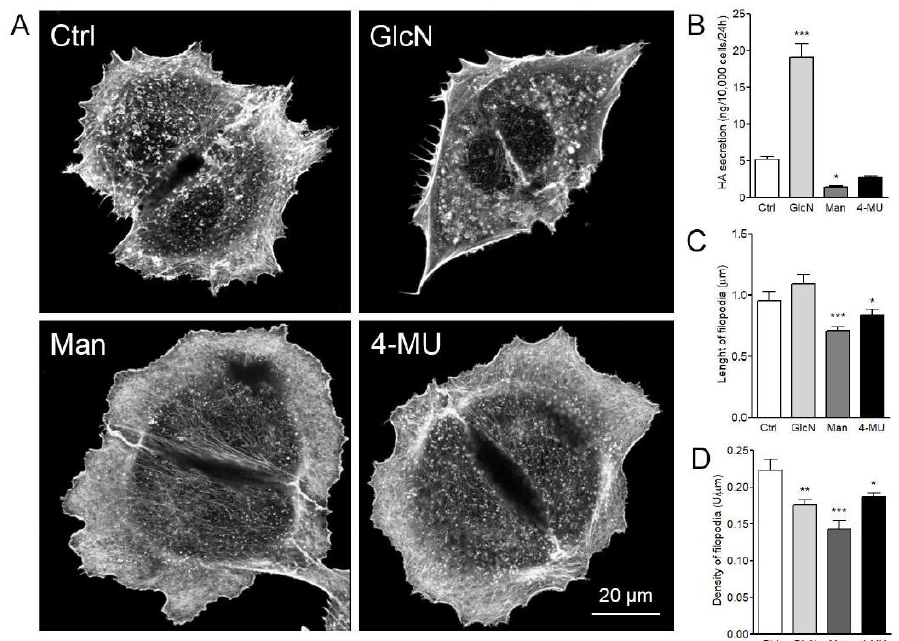
Figure 5. Effect of glucosamine, mannose, and 4-methylumbelliferone (4-MU) treatments on the formation of HAS3-induced filopodia. ( A ) Examples of analyzed GFP-HAS3 expressing fixed and phalloidin-stained MCF-7 cells with different treatments are shown in and ( B ) analysis of hyaluronan secretion, ( C ) length, and ( D ) density of filopodia. One-way ANOVA, * p < 0.05, ** p < 0.01, *** p < 0.001, as compared to control ( n = 5 independent experiments with 16–28 cells/group in each experiment).